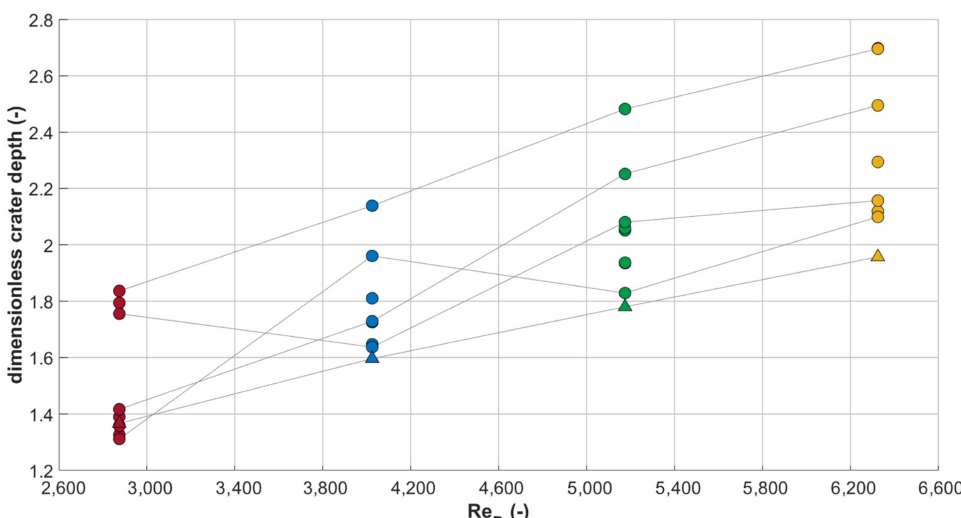
Figure 11. Maximum dimensionless crater depths for multiple drop impacts as a function of the Reynolds number. Circle markers are used for the points corresponding to the simulations with between four and nine drops, while the triangle markers for the results from the 30 drop simulations; the colors are related to the different impact velocities (brown 1.0 m/s, dark cyan 1.4 m/s, green 1.8 m/s, yellow 2.2 m/s).